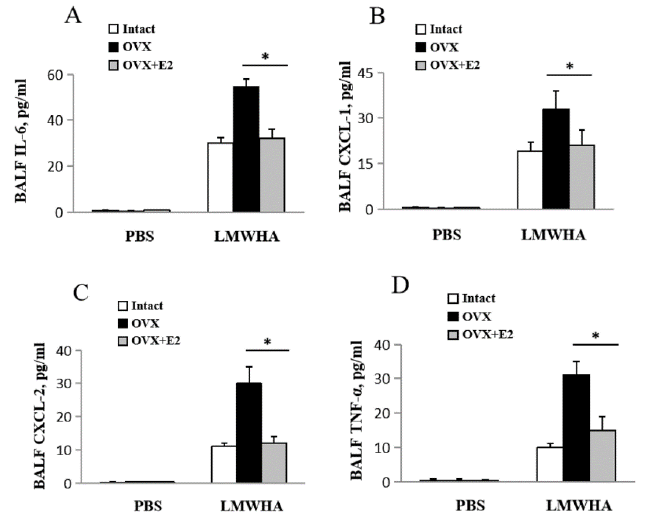
Figure 4. Effects of OVX mice treated with 17 β -estradiol (E2) on inflammatory cytokine production. After a recovery period of at least two weeks, each OVX mouse received daily subcutaneous injection of either vehicle (sesame oil, 2 mL/kg BW) or E2 (twice a day, 3 µ g/kg BW) for one week. ( A ) IL-6, ( B ) CXCL-1, ( C ) CXCL-2, and ( D ) TNF- α in BALF were analyzed 12 h after intratracheal administra- tion of LMWHA (200 kDa, 65 mg/kg). Values are means ± SEM from at least five individual animals. Significant differences are indicated by *, p <